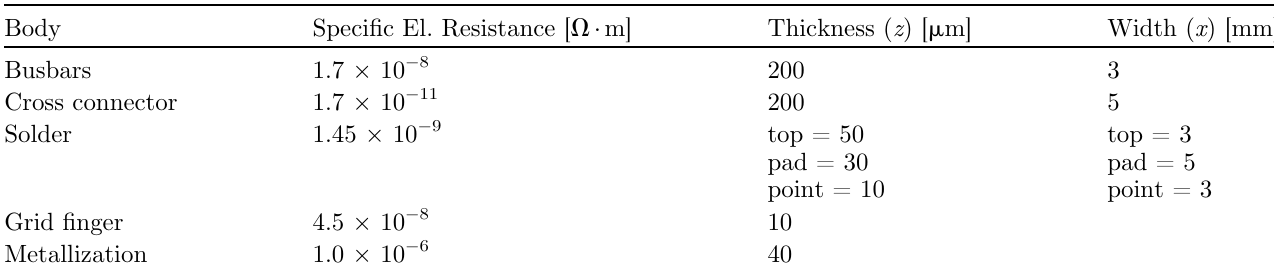
Table 1. Information about the material properties and dimensions of the layers used in the FE-model.